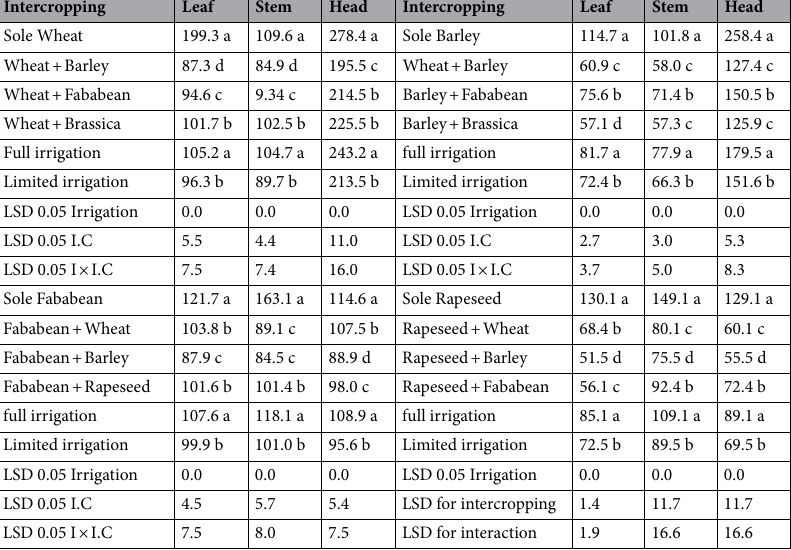
Table 1. Dry matter partitioning (g m −2 ) at anthesis of winter crops as affected by intercropping and irrigation regimes.